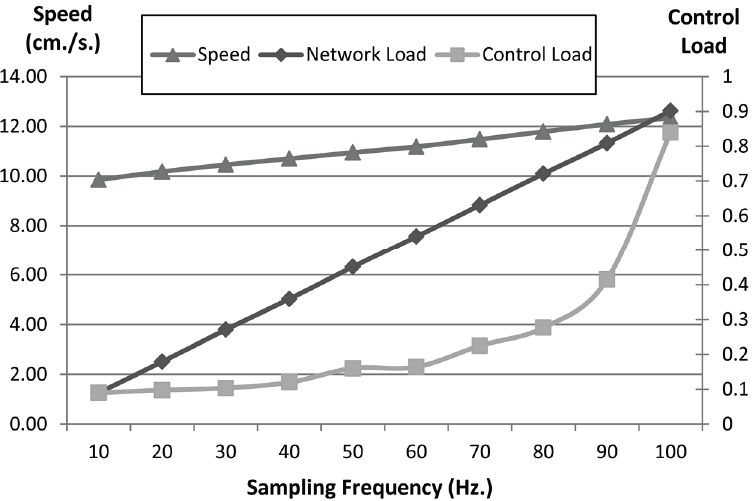
Figure 27. Relation between the sampling rate and the navigation velocity, the communications load and the control load.